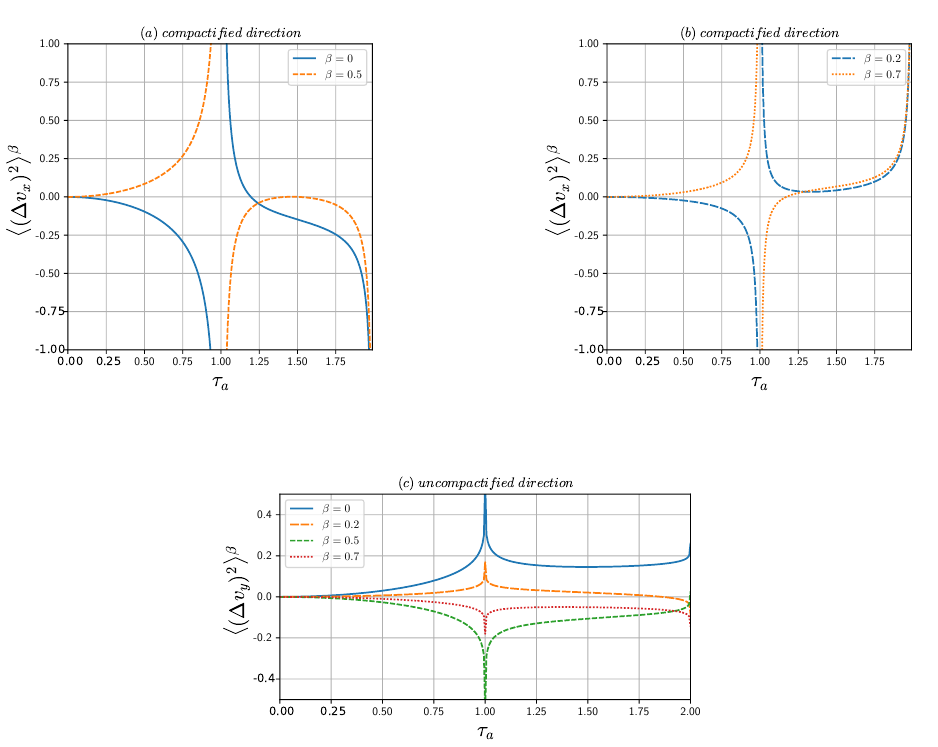
Figure 6 . Graph of the velocity dispersion in the (a)–(b) compactified and (c) uncompacti- fied direction for the Quasiperiodic condition. Here we have considered the curves in units of (cid:16) (cid:17) 2 ma h (∆ v x,y ) 2 i β = h (∆ v x,y ) 2 i β . Note that the shown peaks represent divergent ren g